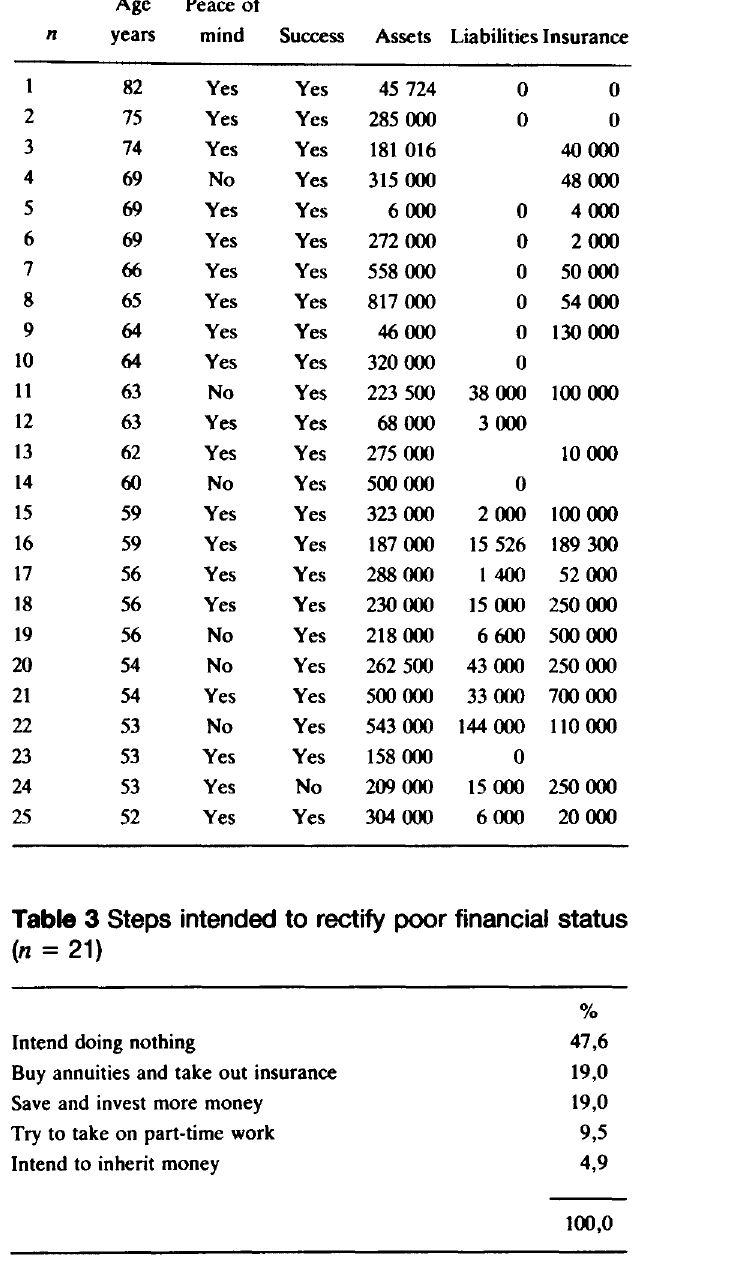
Table 1 Overall results of questions asked.